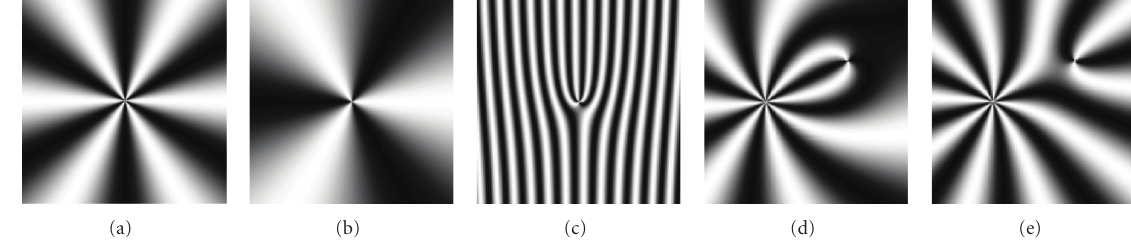
Figure 18: Fringes obtained due to interference between a vortex of charge +3 with (a) another beam with charge − 3 (b) an on-axis plane wave (c) an o ff -axis plane wave. Interferograms obtained when both the interfering beams have o ff centred vortices of (d) opposite unequal charges (e) same signed unequal charges.